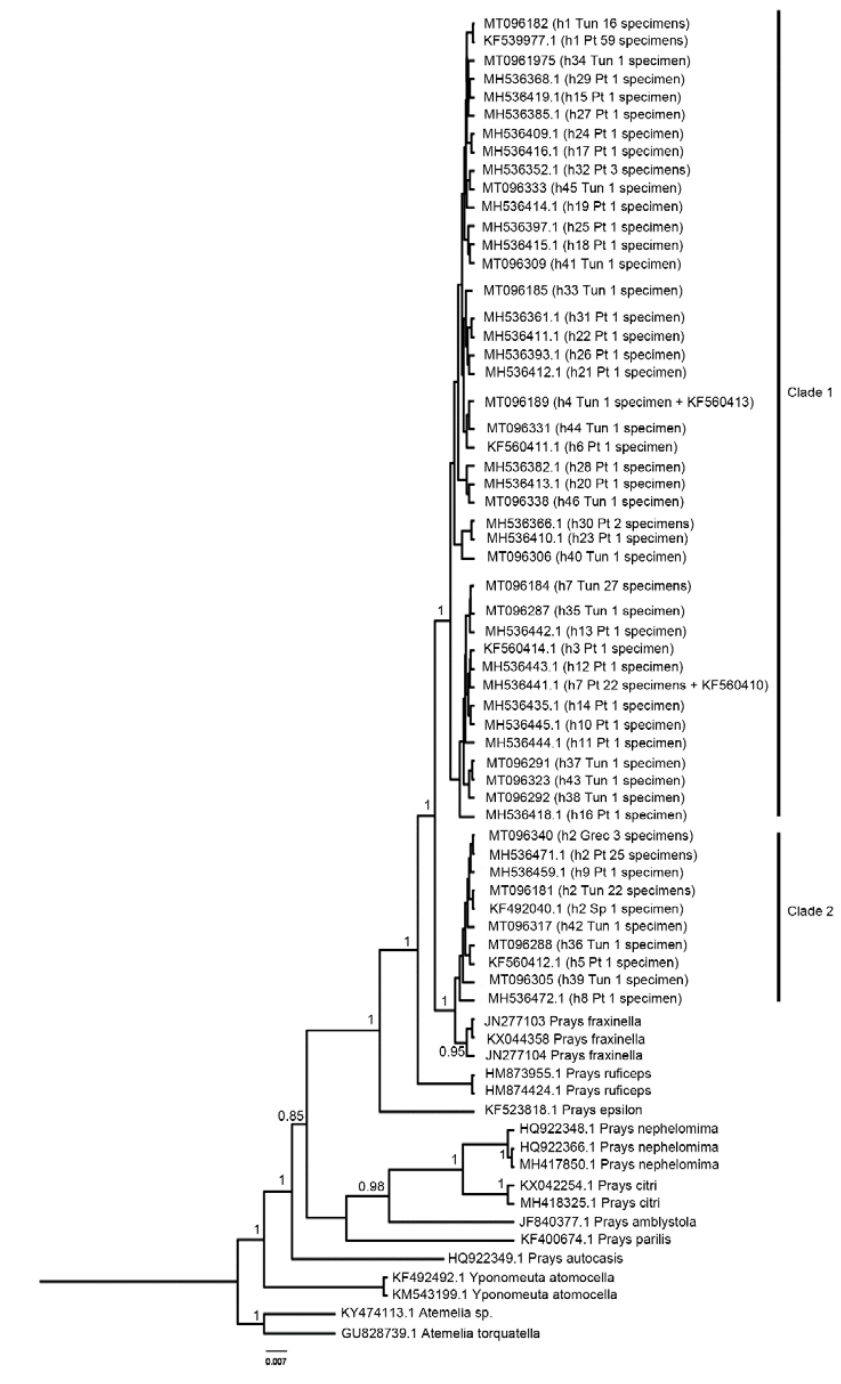
Figure 2. Cytochrome c oxidase subunit I ( COI ) Bayesian inference tree for Prays oleae . Nodes values are Bayesian posterior probabilities. Tree shows a clustering for polymorphic Prays (Clade 1 and Clade 2), suggesting the existence of cryptic species in genus Prays . Putative P. oleae samples collection country identified as: Tun—Tunisia; Pt—Portugal; Sp—Spain; Grec—Greece. Prays fraxinella